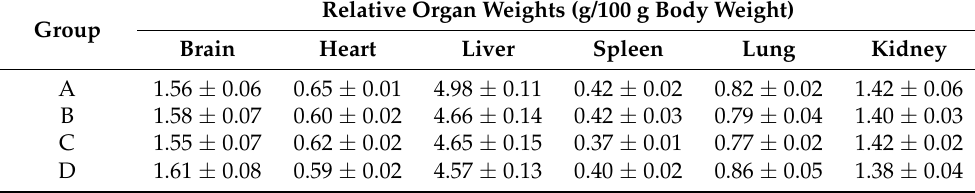
Table 4. Effects of SPE treatment on organ weights of male SAMP8 mice. Group